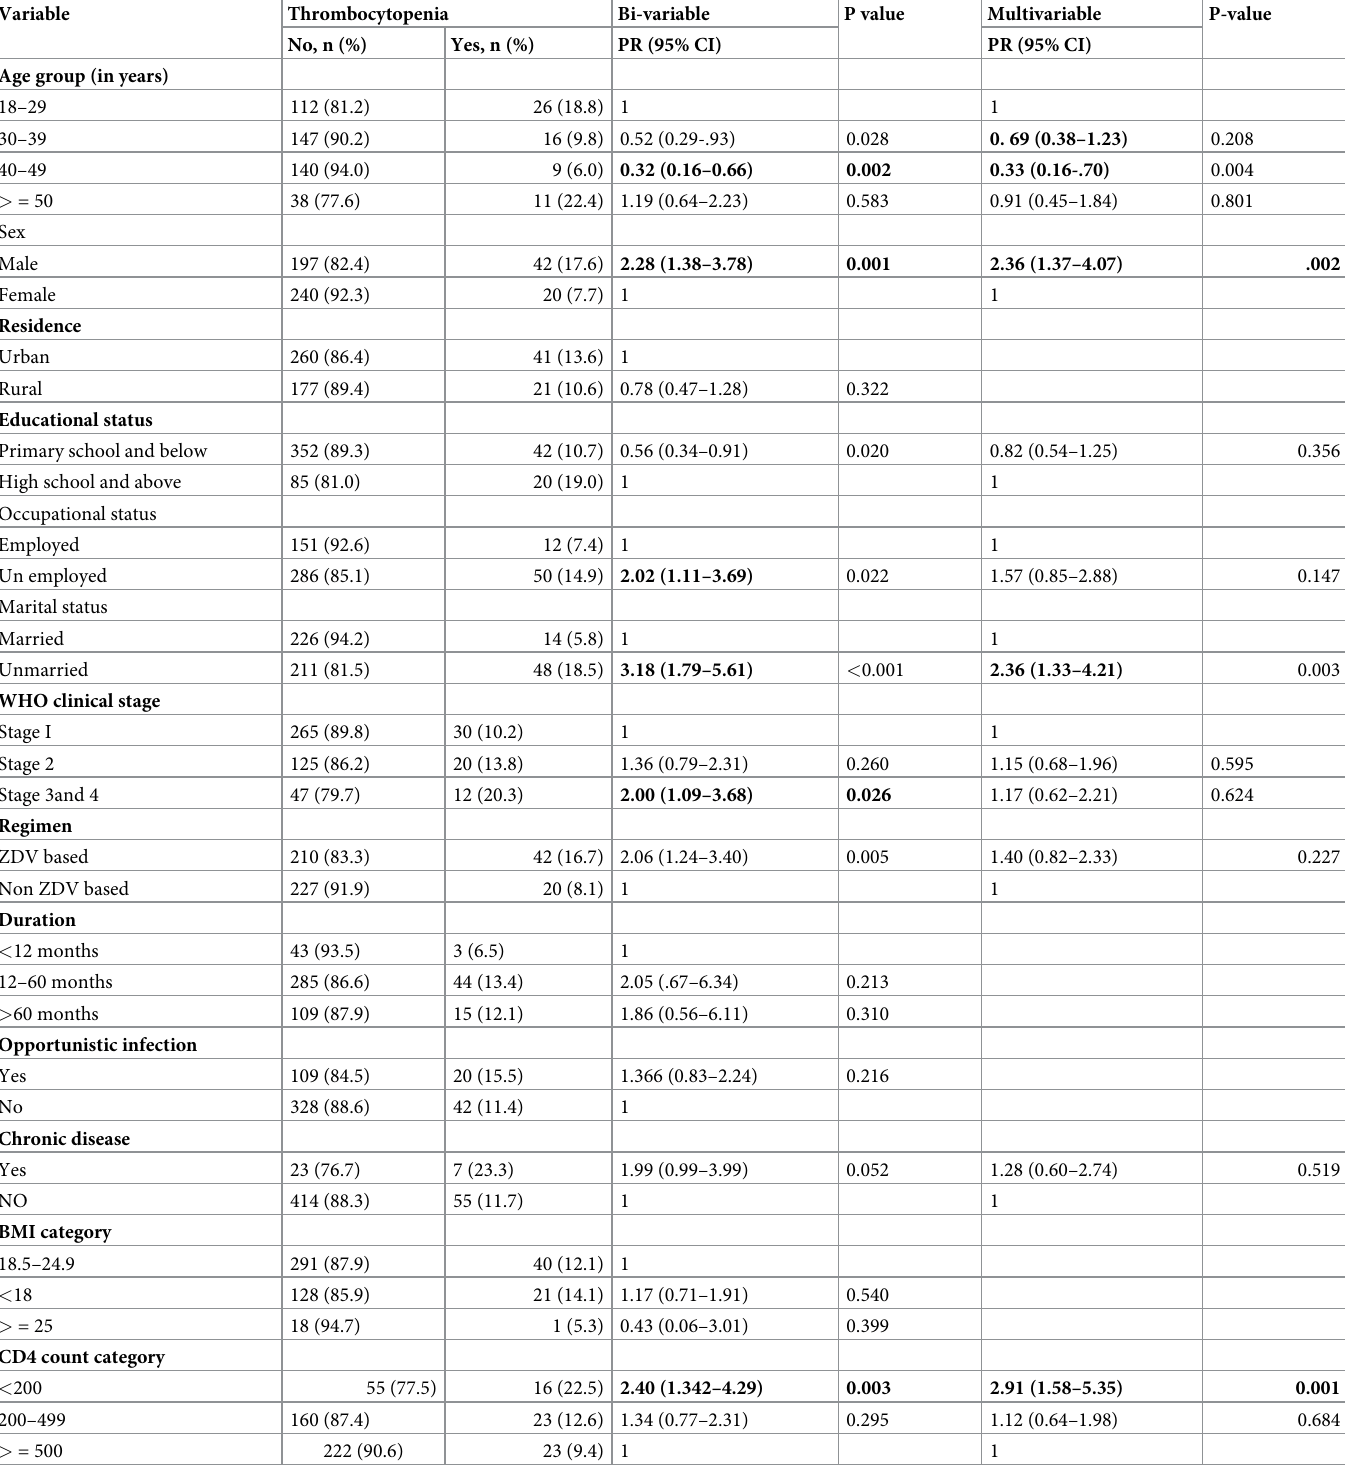
Table 7. Factors associated with thrombocytopenia among HIV infected patients on HAART at Mahal-Meda Hospitals, Northern Shewa Zone, Ethiopia, 2018 (n =